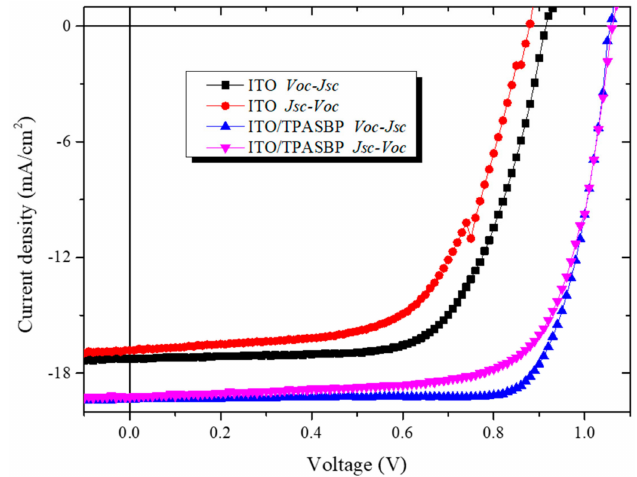
Figure 7. J-V characteristics of inverted PSCs with di ff erent scanning directions.